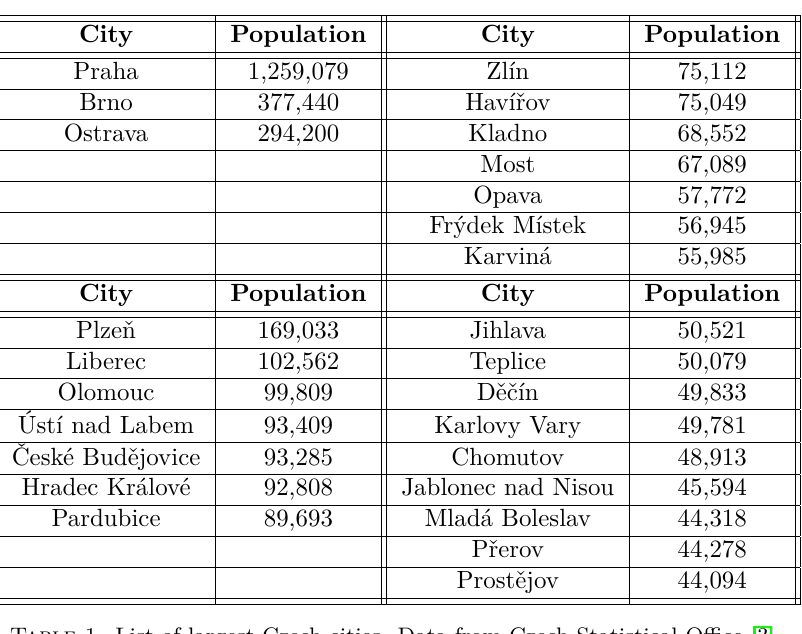
Table 1. List of largest Czech cities. Data from Czech Statistical Office [3].